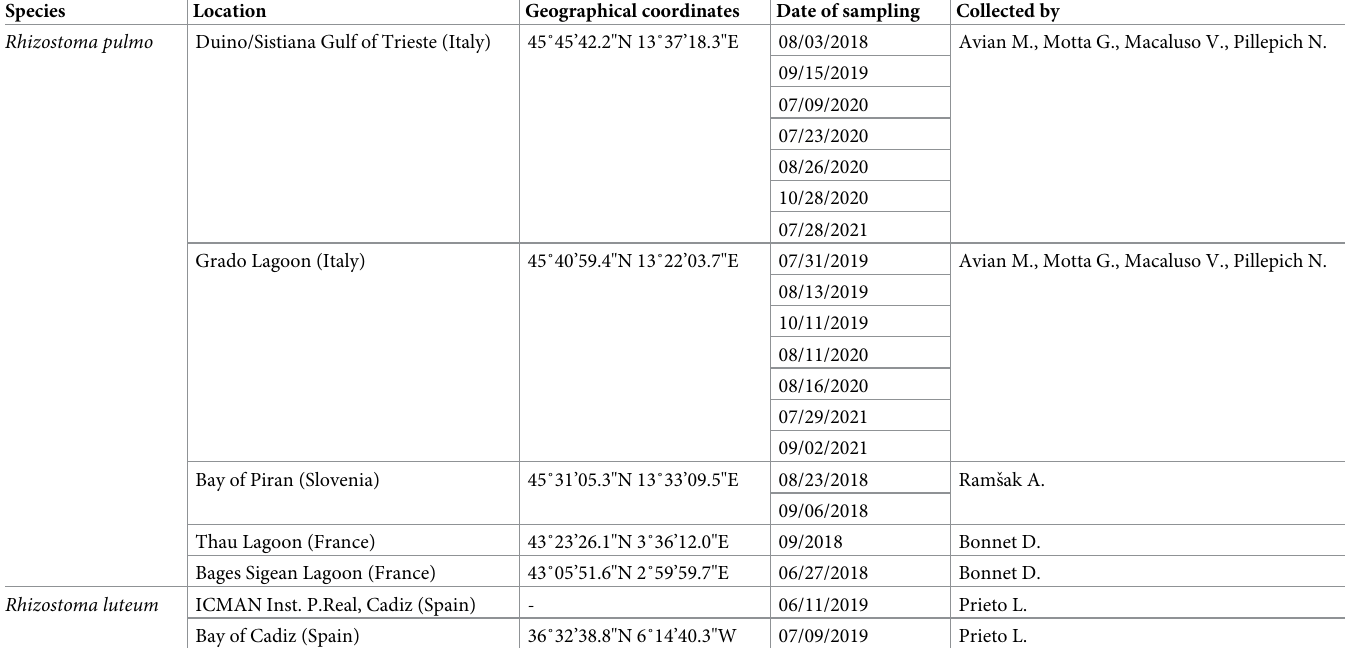
Table 2. List of collected samples and locations for Rhizostoma pulmo and R . luteum . Species